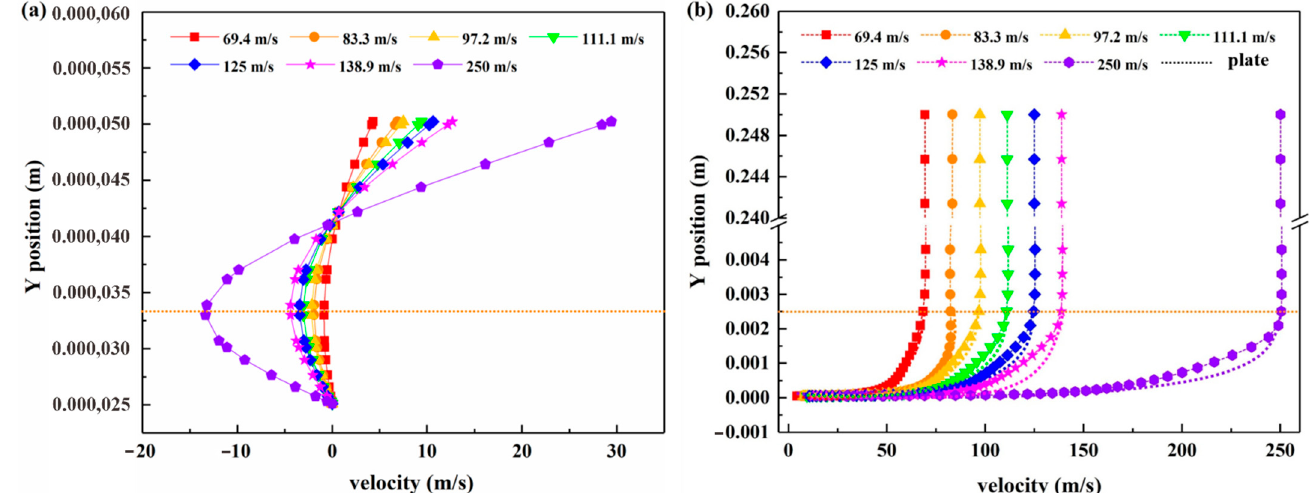
Figure 8. Velocity gradient curves under different flow velocity conditions, ( a ) velocity gradient curves between the bottom and the top of the microstructure, ( b ) velocity gradient curves between the top of the microstructure and the top of the calculation domain.